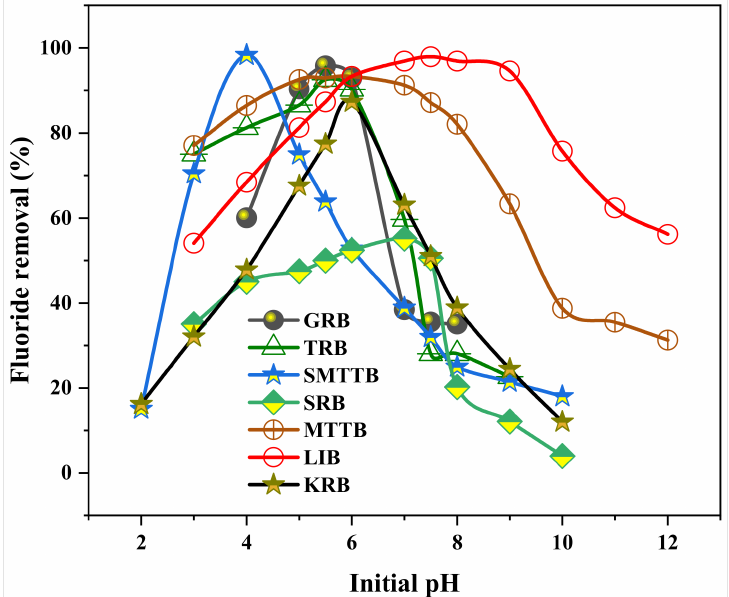
Figure 4. Influence of pH on bauxite adsorption of fluoride. Data gathered from references